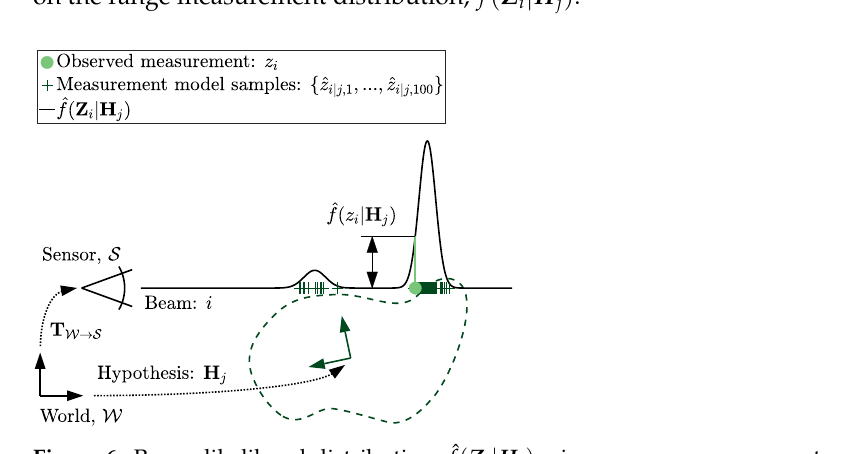
Figure 6. Range likelihood distribution, ˆ f ( Z i | H j ) , given sensor measurement uncertainty, σ and sensor pose uncertainty, Cov ( T W→S )